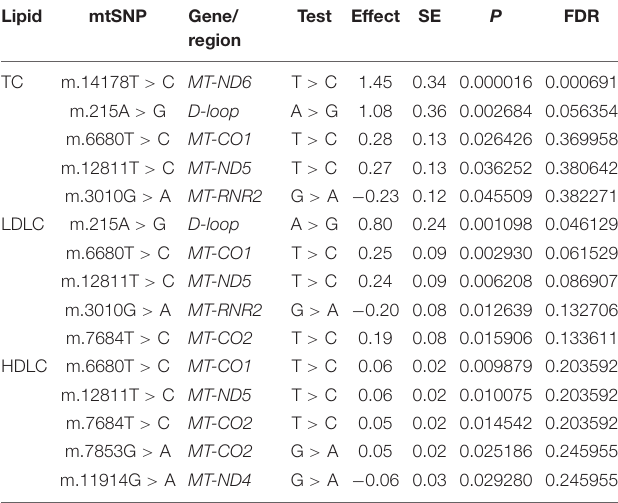
TABLE 3 | Relationships of mtDNA variations with traditional lipids ( P < 0.05).